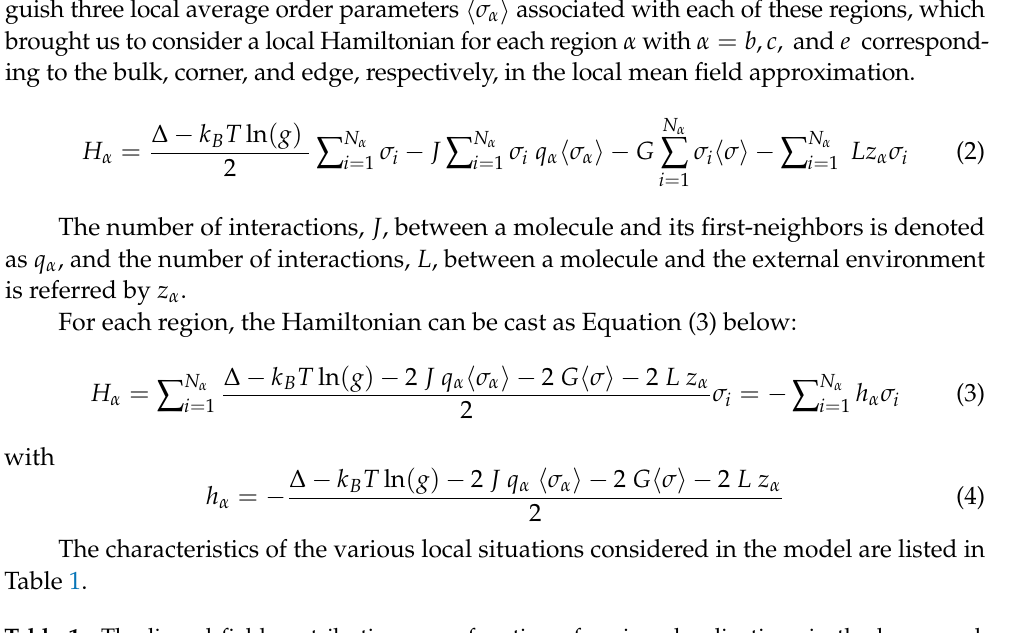
Table 1. The ligand field contributions as a function of various localizations in the hexagonal- shaped